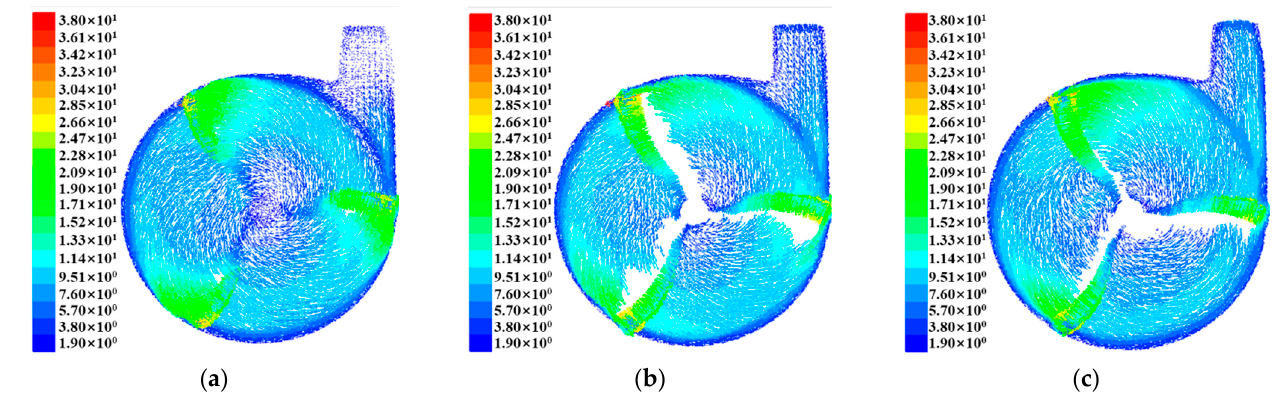
Figure 13. The velocity vector diagram of the crushed straw material phase of different cross-sections along the Y-axis in the impeller volute area. ( a ) Y = − 46 mm. ( b ) Y = 0 mm. ( c ) Y = 46 mm.